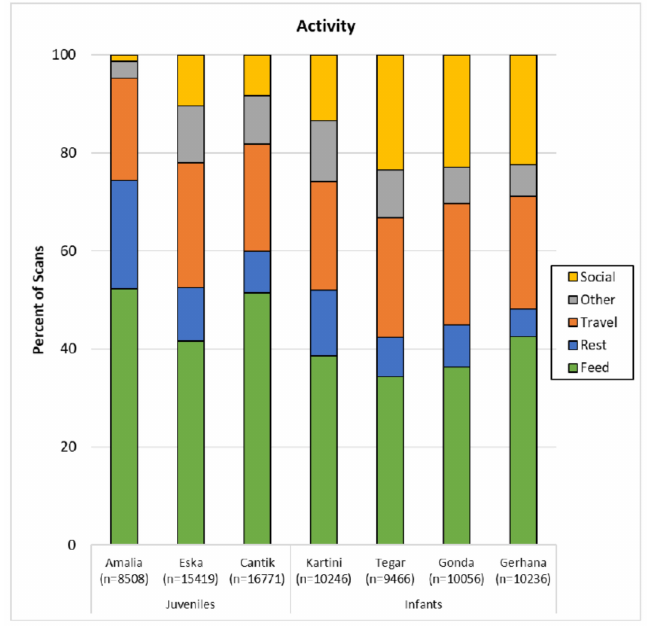
Figure 3. Activity budgets per subject over 18 months (Amalia: over 9 months). N refers to number of scans.